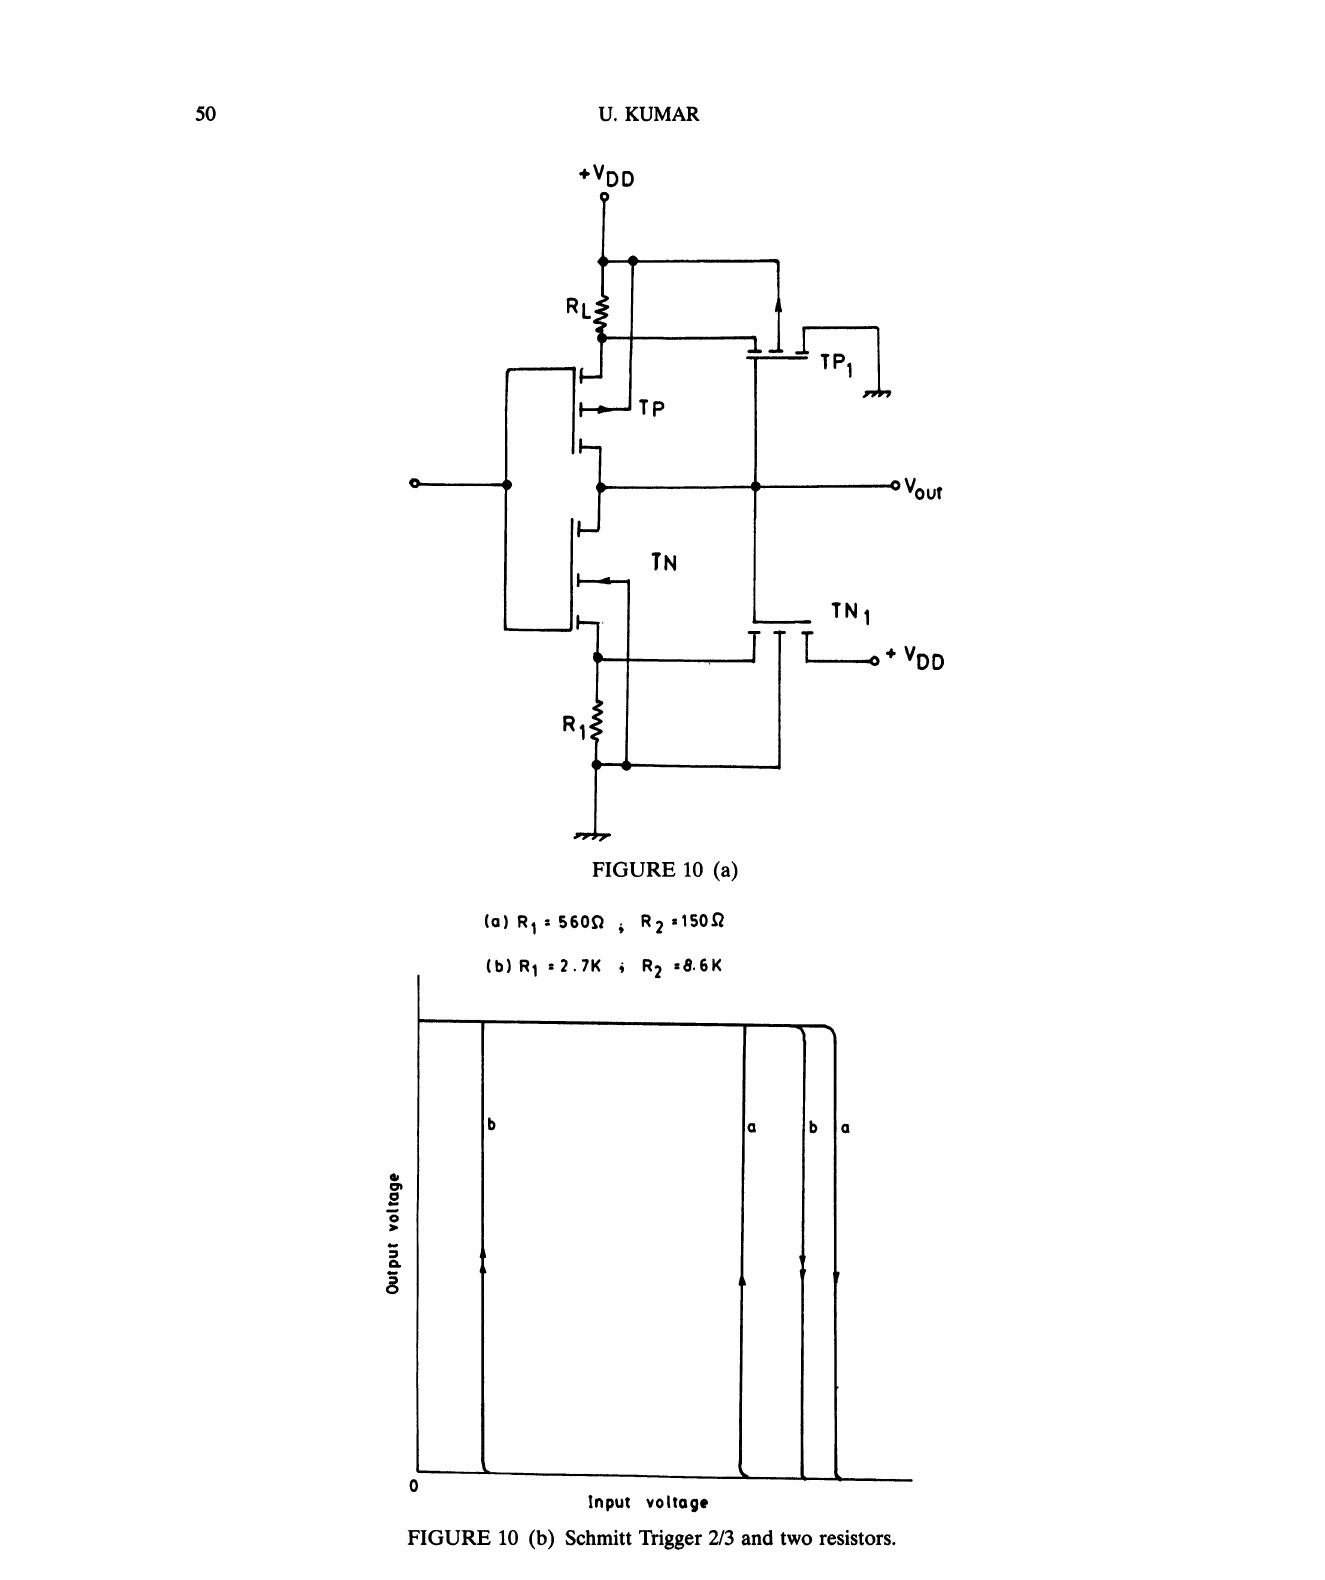
FIGURE 10 (b) Schmitt Trigger 2/3 and two